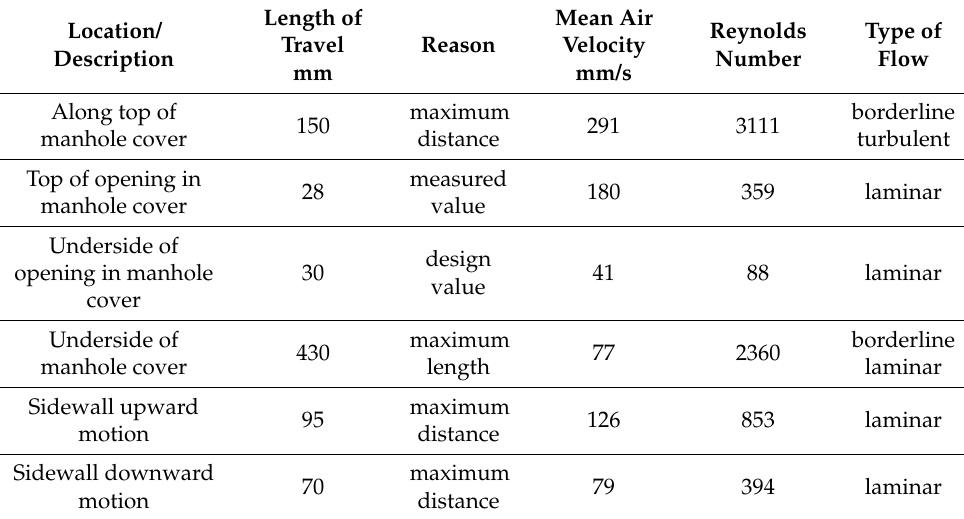
Table 7. Reynolds numbers calculated from measured